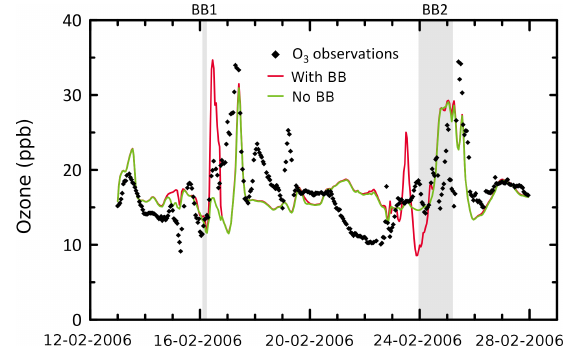
Figure 12. Simulated plume age (green line), simulated combus- tion tracer (NO) (red line), observed O 3 (black symbols) and ob- served HFC-134a (orange symbols) over a 2-week duration of the fire. The modelled BB periods (red peaks) and impact of urban air from mainland Australia (green peaks) are labelled. The periods corresponding to observed BB1 and BB2 are